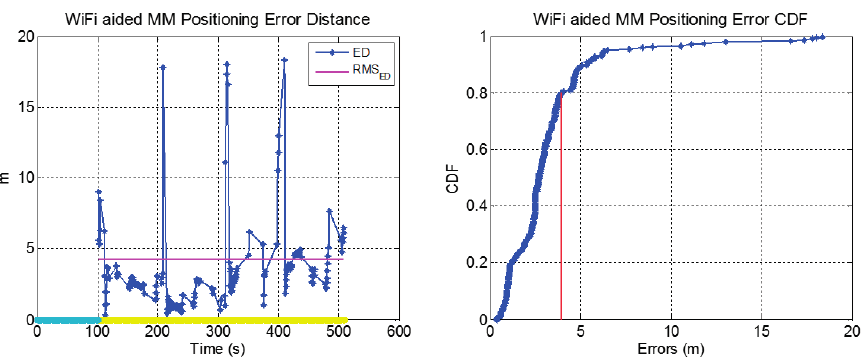
Figure 21. WiFi-aided MM position errors at ENB.